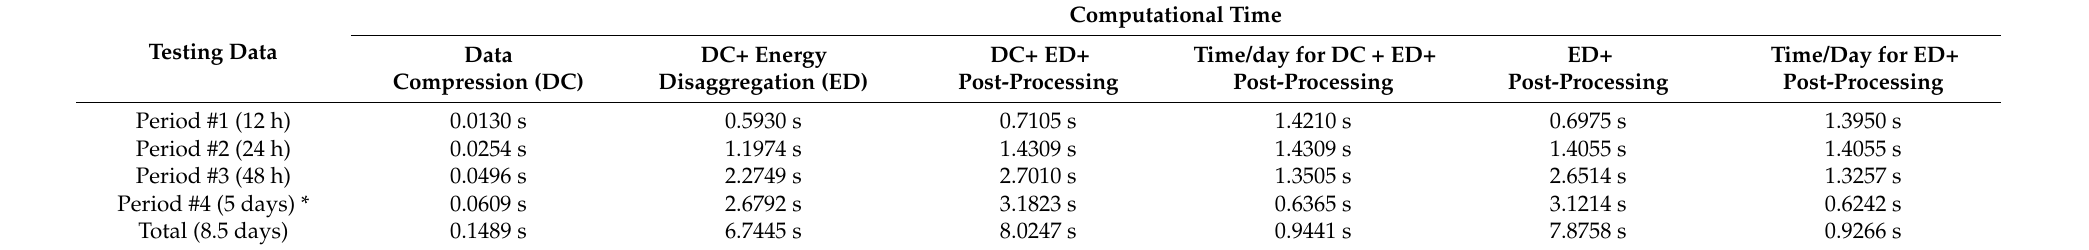
Table 6. Computational time analysis for the proposed